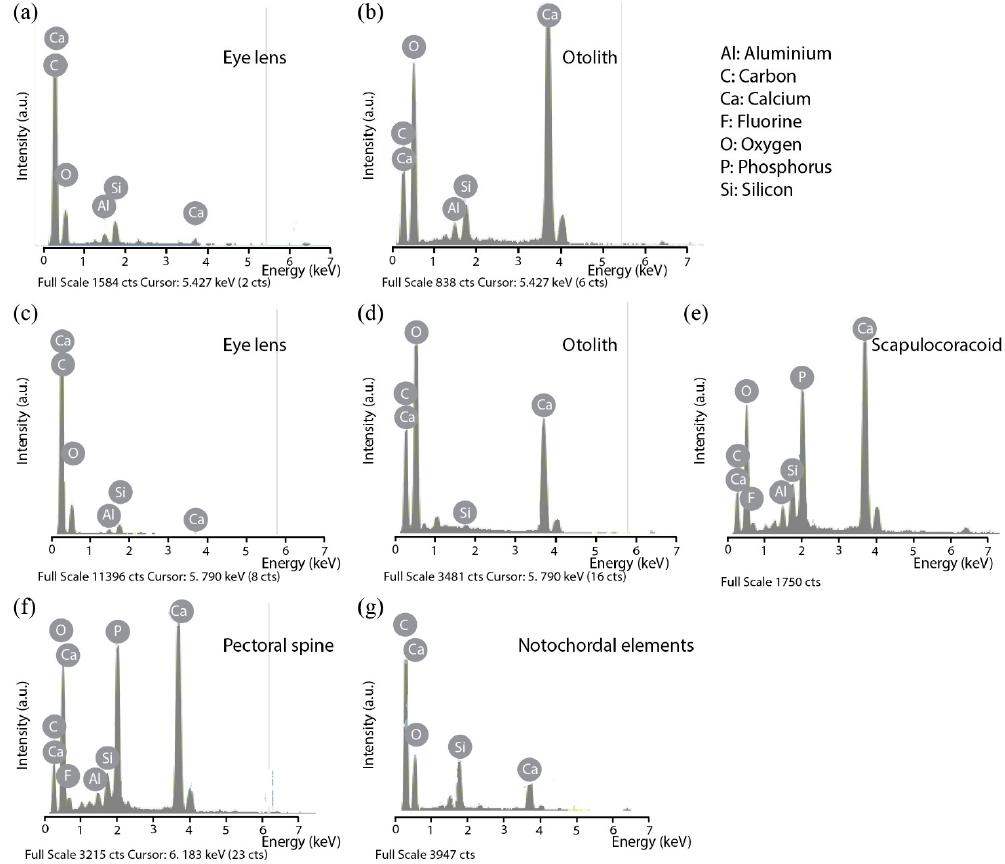
Figure 3. Representative spectra of larval Triazeugacanthus samples using EDX punctual microanalysis. ( a ) and ( b ) MHNM 03-440 #1. ( c )–( g ) MHNM 03-440 #2. Note that the intensity of the oxygen peak